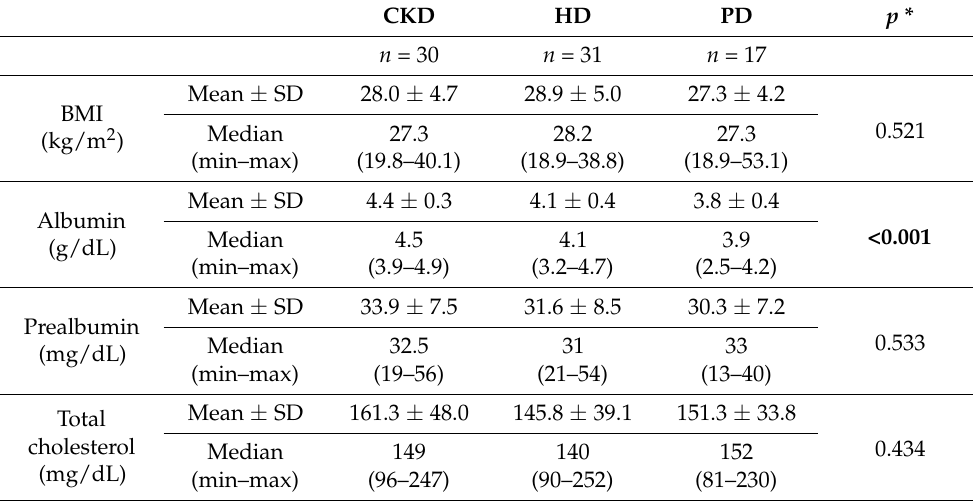
Table 2. Selected parameters of nutritional status in the study